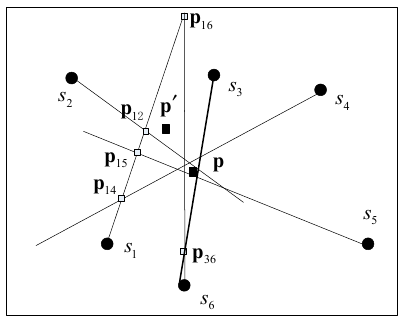
Figure 3. Illustration of the intersection points (IPs) distribution when one bearing is